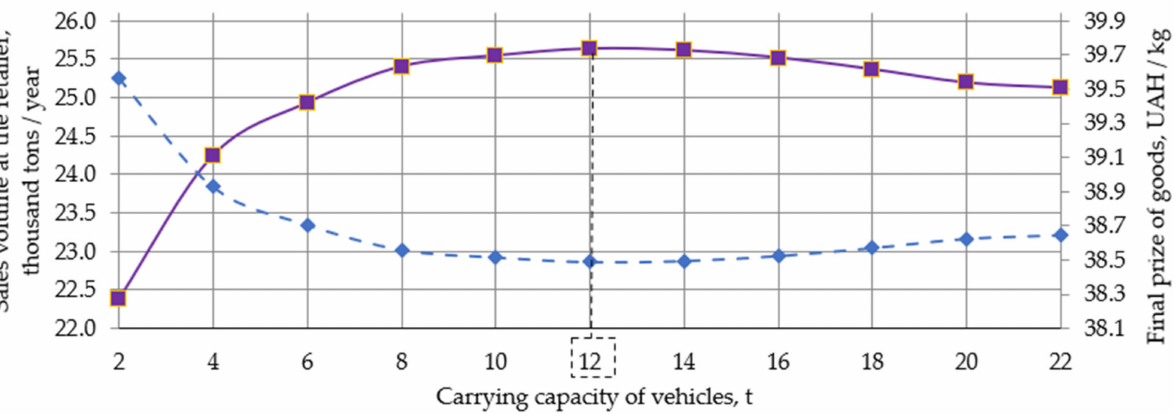
Figure 8. Patterns of sales volume and its final prize for end-consumer depending on the load capacity of vehicles: